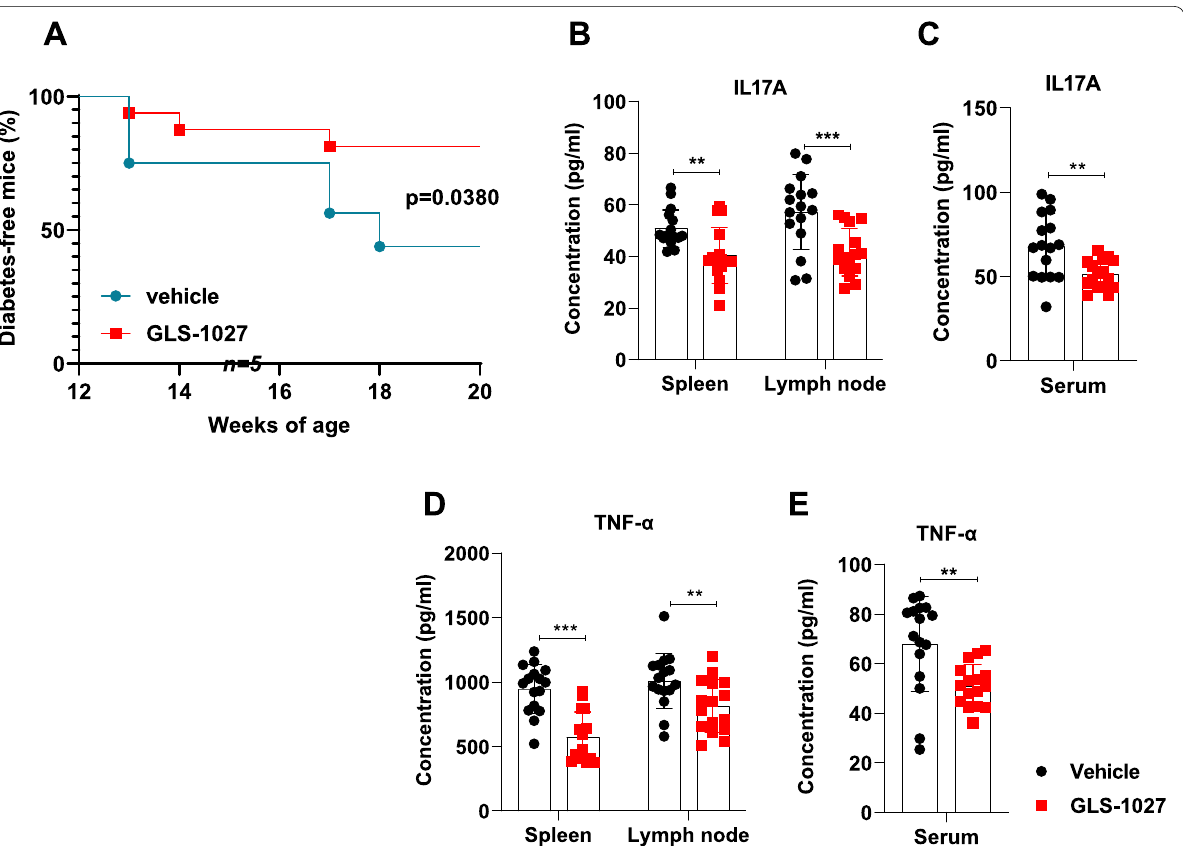
Fig. 5 GLS-1027 prevents type 1 diabetes in the NOD mouse. (A) Eight to nine weeks-old female NOD mice were treated with GLS-1027 (5 mg/ mouse) under a late prophylactic regime, from 10 to 20 weeks of age ( n 16 per group). Blood glucose was monitored and mice with blood = glucose levels 11 mmol/L on two consecutive occasions were considered diabetic. Diabetic mice were sacrificed the day when diagnosis was ≥ confirmed. (B) Spleens and pancreatic lymph nodes were aseptically isolated from the mice and cells from spleen (10 6 /well) or lymph nodes (5 10 5 /well) were cultured with Concanavalin A (Con A; 2.5 μg/ml) in the of culture medium for 48 h. The concentration of IL-17A in the culture × media was measured by ELISA. (C) Serum samples were obtained from terminal blood samples collected immediately after CO 2 euthanasia and assessed for IL-17A levels via ELISA. (D) Spleens and pancreatic lymph nodes were aseptically isolated from the mice and cells from spleen (10 6 / well) or lymph nodes (5 10. 5 /well) were cultured with Concanavalin A (Con A; 2.5 μg/ml) in 1 ml of culture medium for 48 h. The concentration of × TNF-α in the culture media was measured by ELISA. (E) Serum samples were obtained from terminal blood samples collected immediately after CO 2 euthanasia and assessed for TNF-α levels via ELISA. Treatment with GLS-1027 resulted in a dose-dependent inhibition of cytokines. Error bars in all panels indicate 1 standard deviation among 3 replicates per